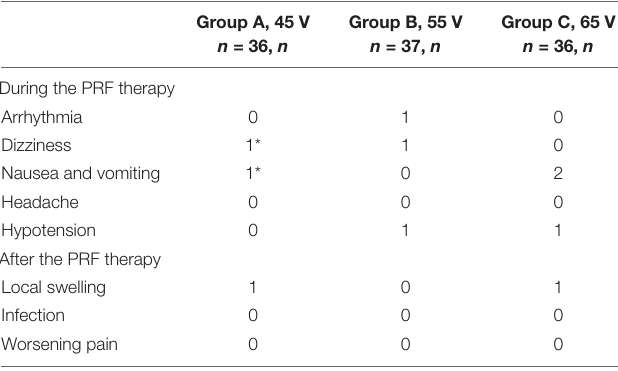
TABLE 4 | Adverse events about various voltage parameters